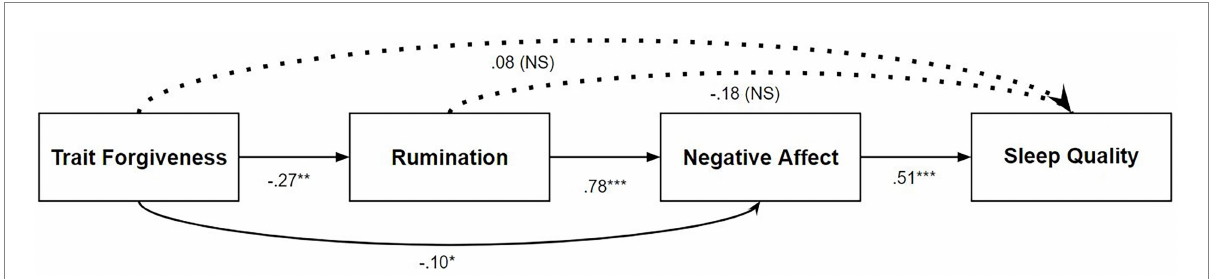
FIGURE 1 We tested an indirect effect of trait levels of forgiveness on sleep quality through trait rumination and negative affect in PROCESS 3.5.3 using Model 6. The measures used in the model, from left to right were the Trait Forgiveness Scale (TFS), the Ruminative Response Scale (RRS), the combined Depression Anxiety Stress Scale (DASS) assessing negative affect, and the Pittsburgh Sleep Quality Index (PSQI). We report standardized coefficient betas for direct paths tests, followed by the completely standardized effects for the two reliable indirect effects. Trait forgiveness was associated with trait rumination ( b = − 0.27, SE = 0.17, 95% CI = − 0.94 to − 0.28), rumination was related to negative affect ( b = 0.78, SE = 0.05, 95% CI = 0.75–0.95), and negative affect was related to sleep quality ( b = 0.51, SE = 0.004, 95% CI = 0.01–0.03). The path from trait forgiveness directly to negative affect was also significant ( b = − 0.10, SE = 0.11, 95% CI = − 0.48 to − 0.03). The path from trait rumination to sleep quality was not significant ( b = − 0.18, SE = 0.004, 95% CI = − 0.02 to 0.002). Further, the direct path from trait forgiveness to sleep quality was not significant ( b = 0.08, SE = 0.01, 95% CI = − 0.01 to 0.02). Overall, as predicted, the model showed that trait forgiveness was associated with sleep quality via two significant indirect effects: through both trait rumination and negative affect ( b = − 0.11, SE = 0.04, 95% CI = − 0.18 to − 0.04), and through negative affect alone ( b = − 0.05, SE = 0.02, 95% CI = − 0.09 to − 0.01).